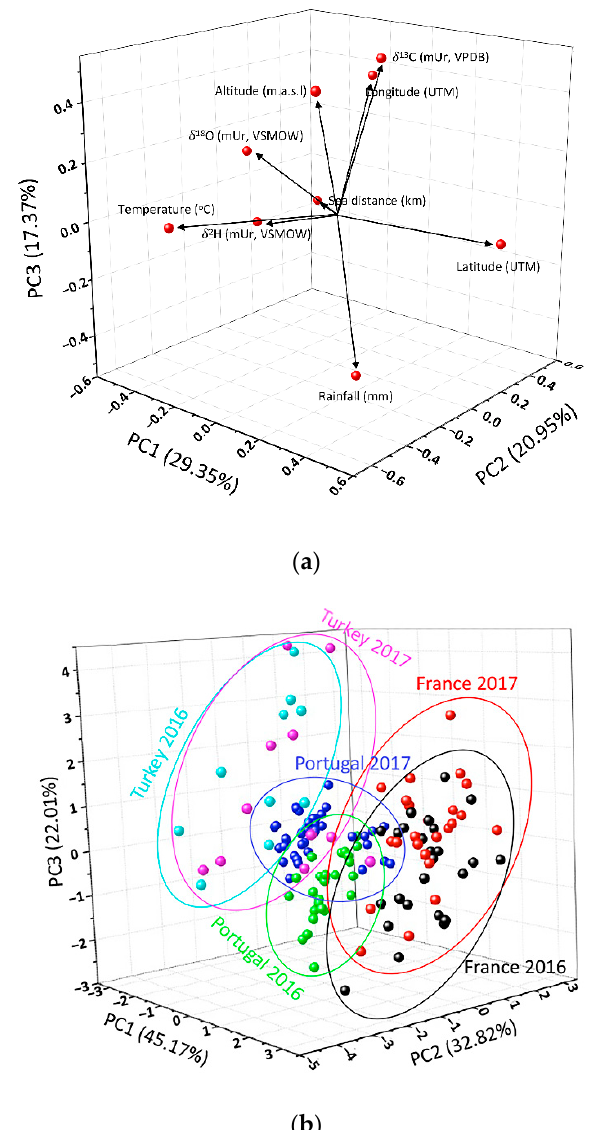
Figure 3. Principal components analysis (PCA). ( a ) 3D Plot of component weights for the geographical variables and the carbon, oxygen and hydrogen ( δ 13 C, δ 18 O and δ 2 H) isotope composition of VOO samples; ( b ) 3D Score plot of VOO samples from France, Portugal and Turkey in 2016 and 2017.